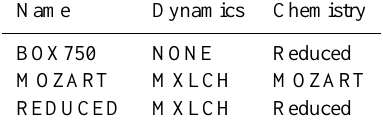
Table 2. Initial and boundary conditions used in MXLCH. MXLCH is initiated at 07:00UTC, t is the elapsed time since the start of the simulation and t d is the time in seconds between 07:00–17:00UTC.